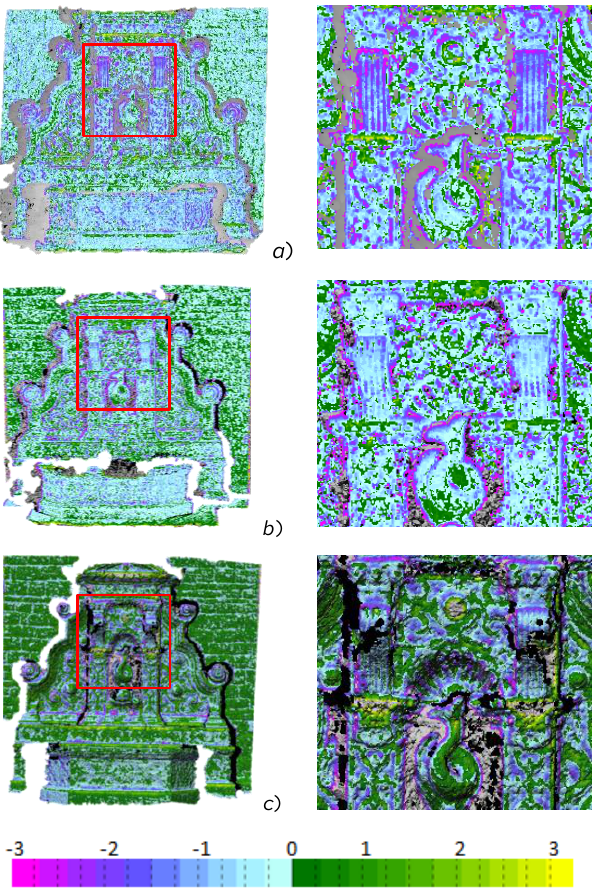
Figure 6: Fountain Error map (cm): ( a ) SGM, ( b ) MicMac, ( c ) PS - with a zoom (on the right) on a delimited